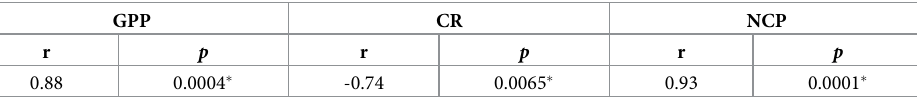
Table 3. Spearman correlations between carbon community metabolism (mmolC m -2 d -1 ) and temperature (˚C) along the experimental period. GPP CR NCP r p 0.88 0.0001 � GPP: Gross primary production; CR: Community Respiration; NCP: Net community production. r is the correlation coefficient. Asterisks ( � ) indicate significant differences at p <